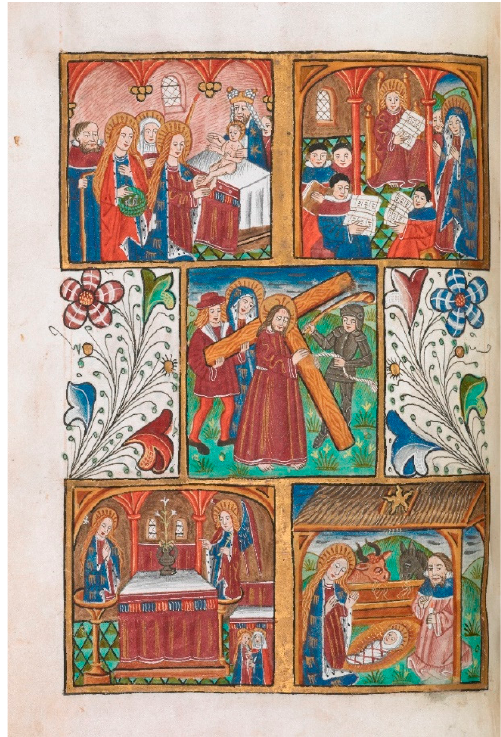
Figure 4. Pictorial cycle ahead of the Fifteen Oes in the Hours of the Earls of Ormond, f.56v, © British Library Board.